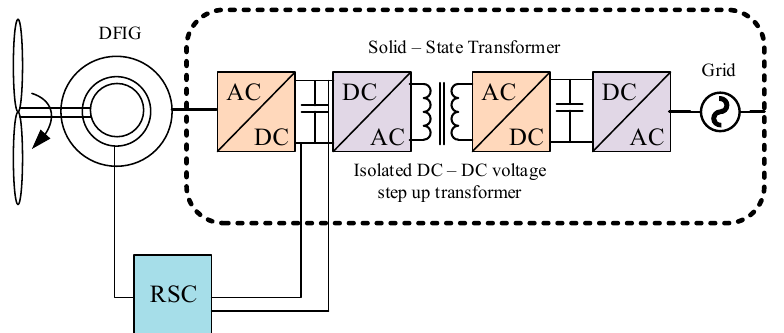
Figure 7. Double-fed induction generator-based wind energy conversion system in SST applications.